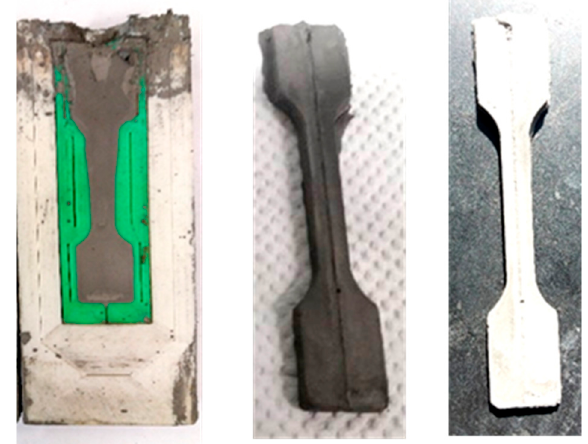
Figure 10. ABS split mold with green and sintered MIM parts.